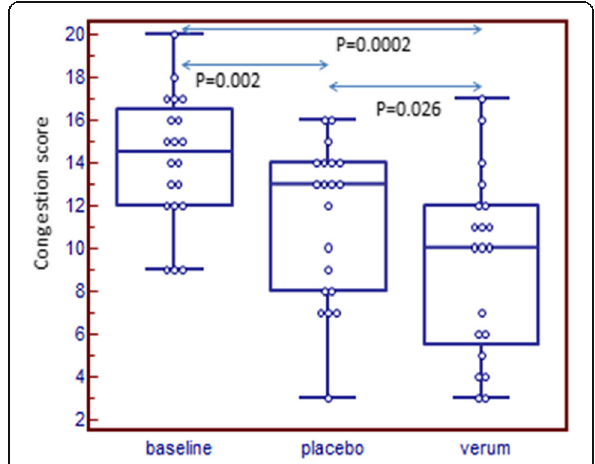
Fig. 3 Congestion score improvement from baseline with the herbal spray (verum) and placebo